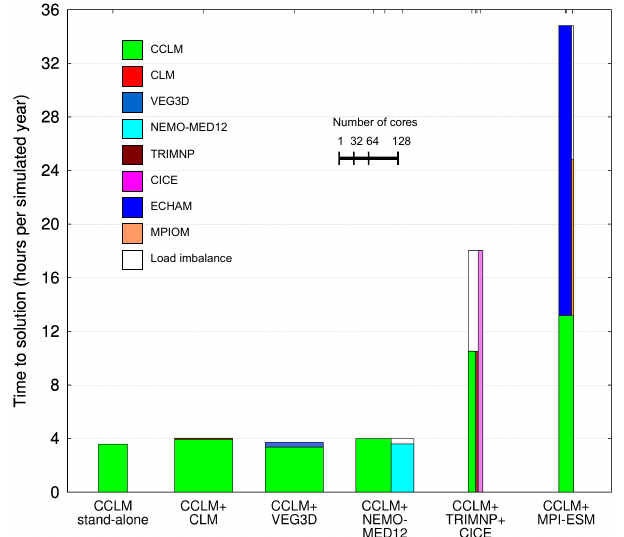
Figure 6. Time to solution and cost of components of the coupled systems at optimum configuration of couplings investigated and of stand-alone CCLM. The boxes’ widths correspond to the number of cores used per component. The area of each box is equal to the costs (the amount of core hours per simulated year) consumed by each component calculations, including coupling interpolations. The white areas indicate the load imbalance between concurrently running components. See Table 8 for